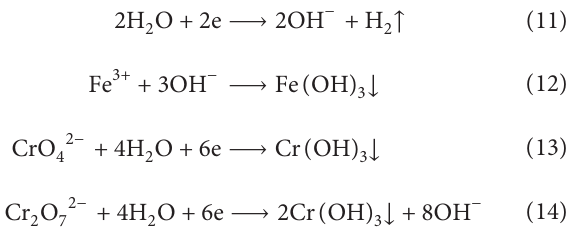
Figure 11: SEM surface images after static (a–c)) and dynamic (d–f)) pickling in 300gL − 1 H 0.04A cm − 2 (a and d), 0.12A cm − 2 (b and e), and 0.2A cm − 2 (c and